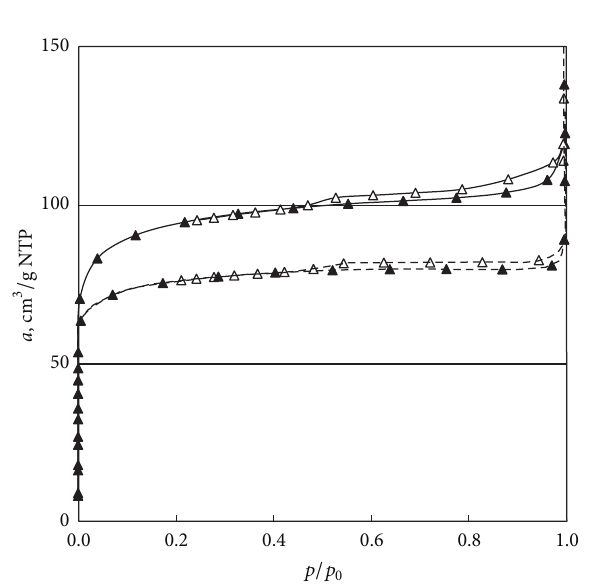
Figure 4: Nitrogen adsorption-desorption isotherms for spent active cokes ACS0 (solid lines) and ACS33 (dashed